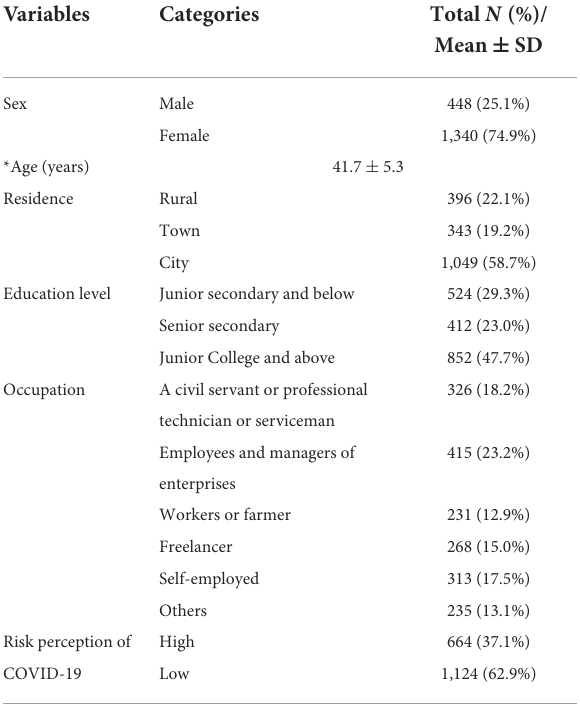
TABLE 1 Demographic characteristics of study participants ( n =